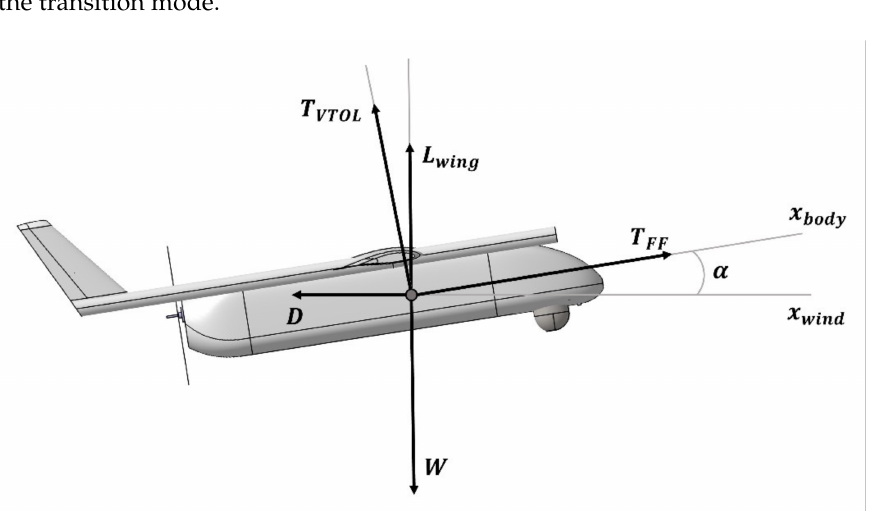
Figure 10. Lift+cruise UAV’s free body diagram during transition